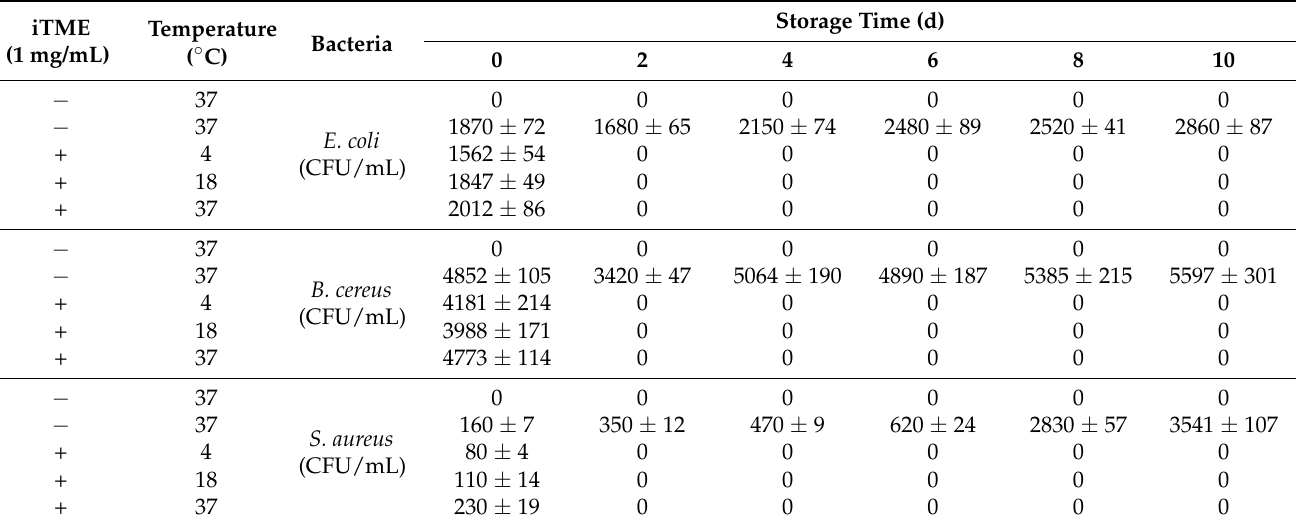
Table 5. Evaluation iTME as a preservative of Korean traditional soy